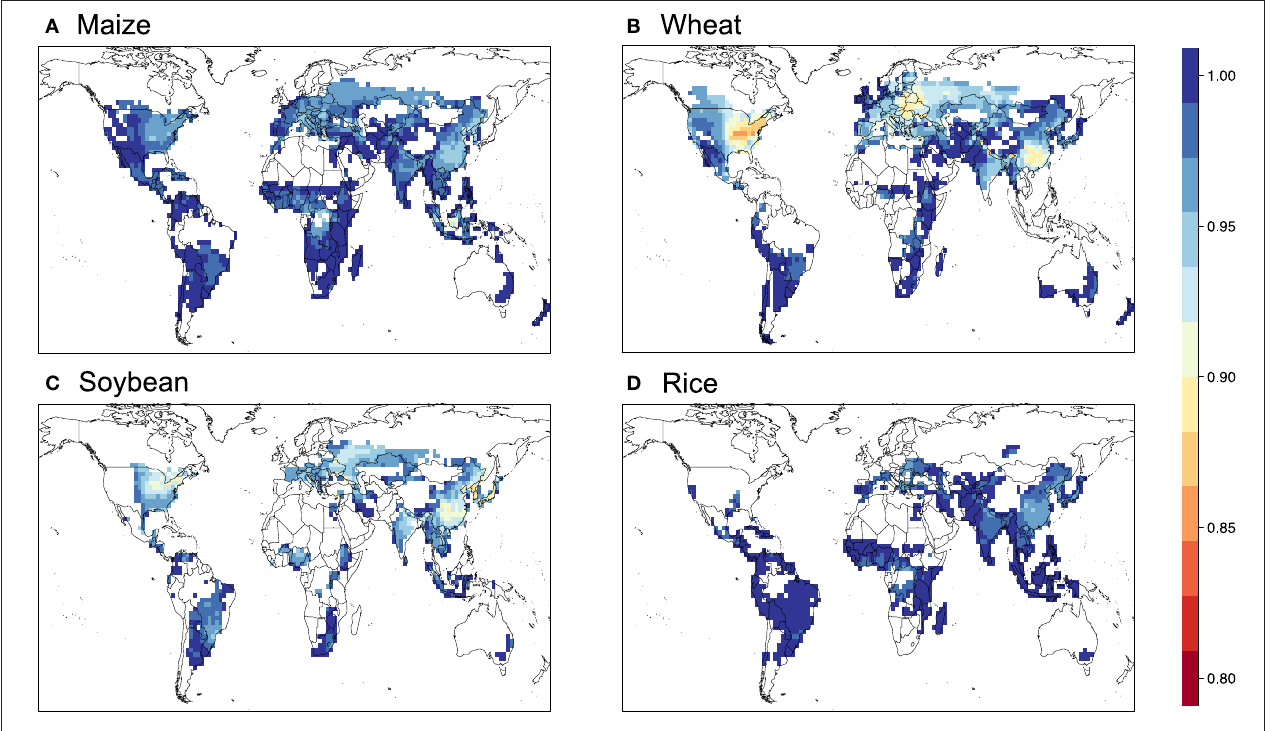
FIGURE 8 | Relative yield based on the flux-based POD 3 metric with DO 3 SE formulation for (A) maize, (B) wheat, (C) soybean, and (D) rice.